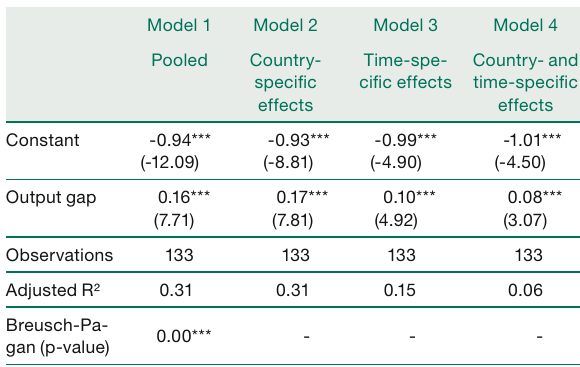
Table 1 Estimation results: EMU Phillips curve with output gap